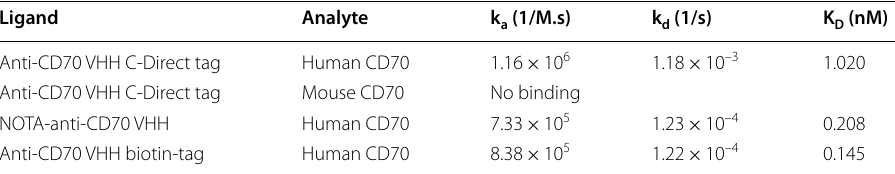
Table 1 Binding affinity kinetics (equilibrium dissociation constant (K dissociation (k ) rates) of anti-CD70 VHHs as determined by SPR d Ligand